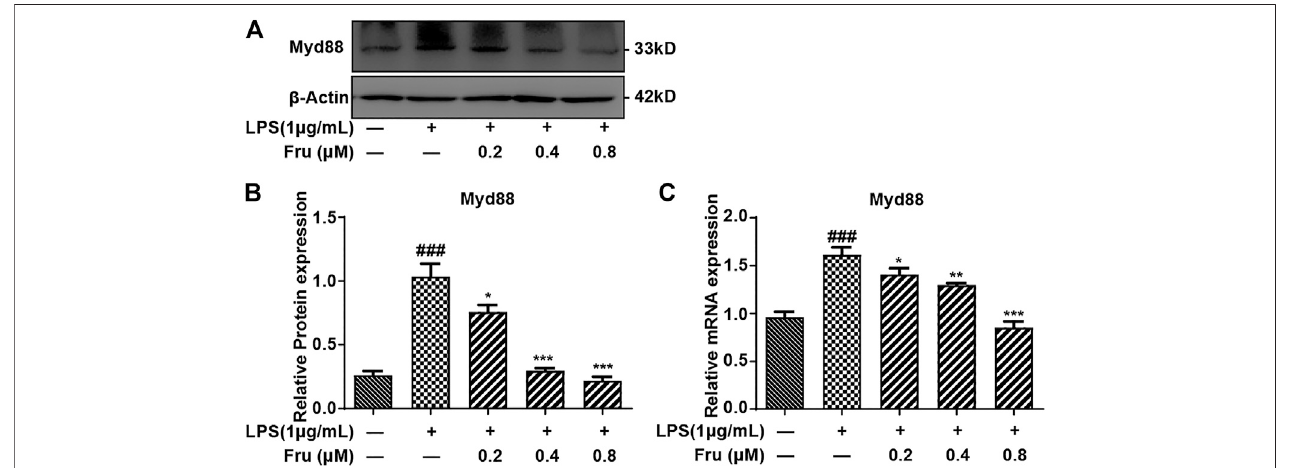
FIGURE5| Frusuppressed theexpressionofMyd88inLPS-inducedRAW264.7 cells.TheRAW264.7cellswerepretreated withFru(0.2,0.4, and0.8 μ M) for2 h and then stimulated withorwithout 1 μ g/ml LPSfor8 h (A,B) Theprotein expression ofMyd88wasevaluatedbyWesternBlot. β -actin wasused asthe internalcontrol. (C) The mRNA expression of Myd88 was evaluated by qRT-PCR and normalized to GAPDH. Quantitative data was represented as mean ± SD ( n (cid:2) 3, ### p < 0.001 vs. Control; * p < 0.05, ** p < 0.01, *** p < 0.001 vs. LPS).